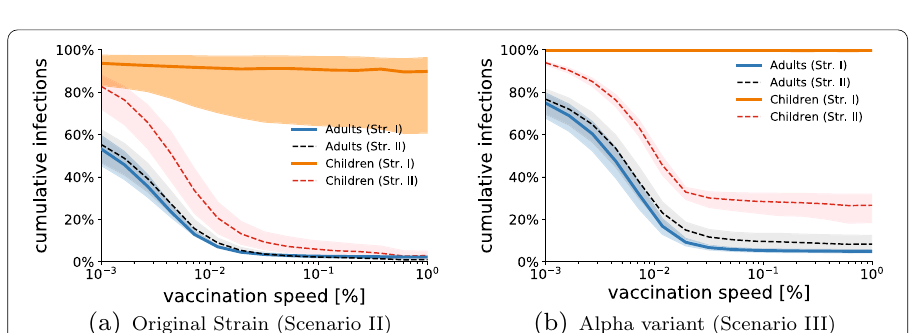
Fig. 10 Effect of vaccination speed. We show the Monte Carlo estimation (over 100 independent simulations) of the cumulative fraction of infections among all adults (blue) and children (orange) at the end of the pandemic outbreak, as a function of the vaccination speed in percentage of the total population daily vaccinated, the vaccination is stopped when V = 60% . The solid curves refer to Vaccination strategy I, in which only adults are eligible for vaccination; the dashed curve refers to Vaccination strategy II, in which vaccine shots are randomly assigned to the entire population. In ( a ), we consider the original strain; the vertical bands represent the confidence interval with respect to the decreased infectiousness of children. In ( b ), we consider the Alpha variant; the vertical bands represent the confidence interval with respect to the increased infectiousness of the Alpha variant. The parameters used in the simulations are listed in Table 2, q a = 0.25 , and q c =